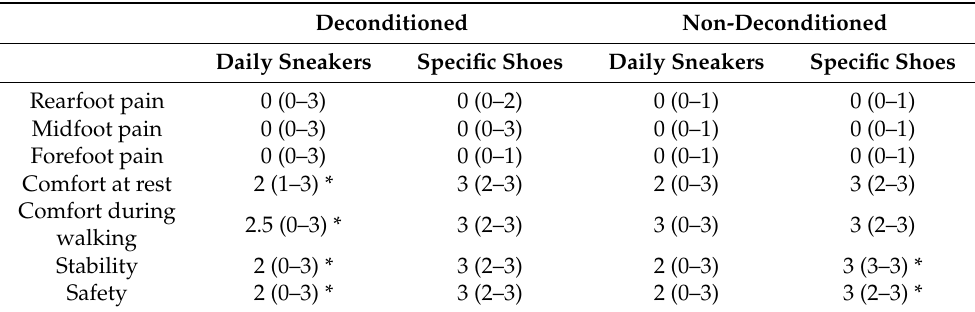
Table 2. Median (minimum and maximum) values of the score for the questionnaire related to comfort for the two groups are reported for the two sessions (daily sneakers vs. specific shoes). * = p < 0.05, statistically significant in the post hoc comparison daily sneakers vs. specific-obesity shoes.